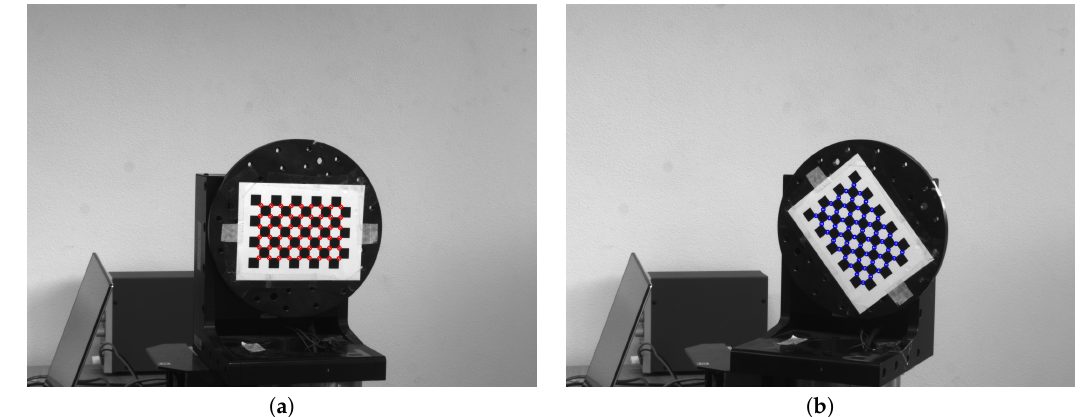
Figure 7. Checkerboard in two different poses and their M highlighted inner corners: ( a ) reference grid ( X R , in red); ( b ) target grid ( X i , in blue).